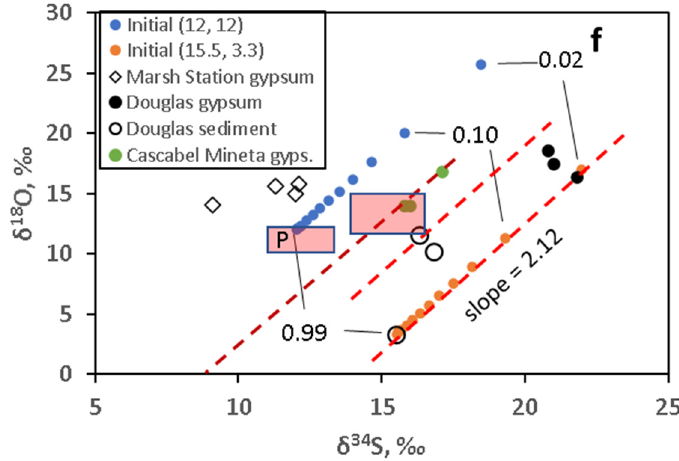
Figure 7. Plots of δ 18 O (sulfate) vs. δ 34 S in gypsum, where fractionation is due to cyclic dissolution and recrystallization with loss of some aqueous sulfate in each cycle. The theoretical values (colored points) were calculated from chosen starting points, using fractionation factors from [47,48]. “f” represents the fraction of original sulfate remaining as gypsum.